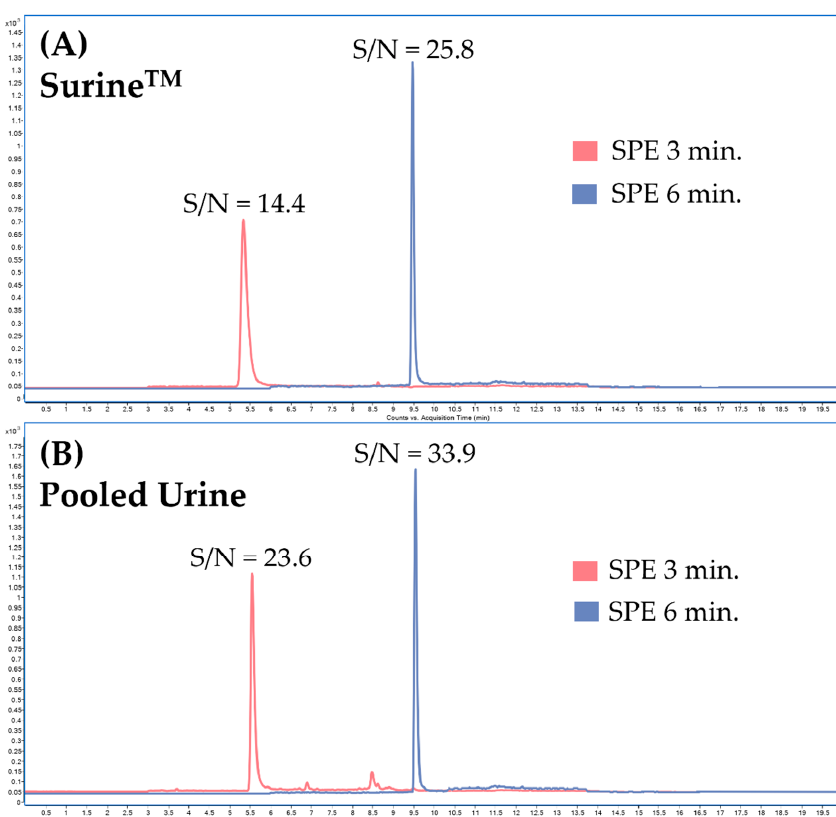
Figure 6. Influence of the loading and washing time of the washing solution (5% methanol) on the signal-to-noise (S/N) ratio of the sample. Clenbuterol multiple reaction monitoring (MRM) chromatogram: ( A ) Surine TM spiked with the standard of clenbuterol with loading and washing time of 3 min or 6 min, ( B ) pooled urine spiked with the standard of clenbuterol with loading and washing time of 3 min or 6 min.